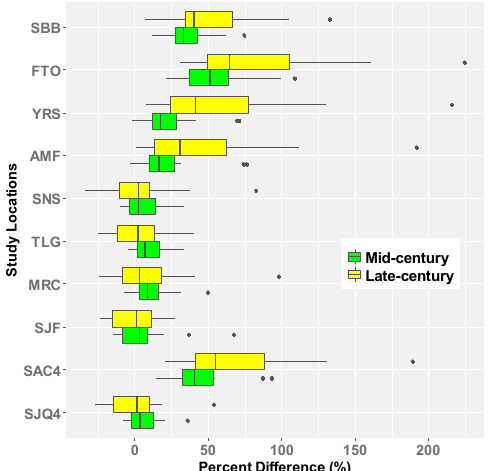
Figure 4. Box-and-whisker plots of percent difference (%) between historical and individual projections on monthly peak runoff volume in mid-century and late-century for all study locations. Each box plot shows information of 20 projections derived from 10 General Circulation Models (GCMs) under two Representative Concentration Pathways (RCPs).